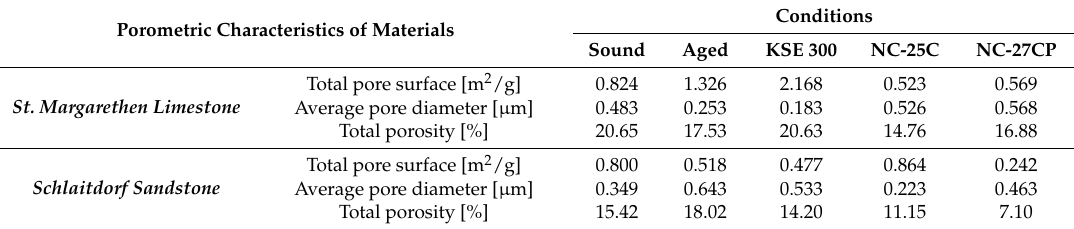
Table 1. Results from mercury intrusion porosimetry for specimens in sound, aged and consolidated conditions for St. Margarethen Limestone and Schlaitdorf Sandstone